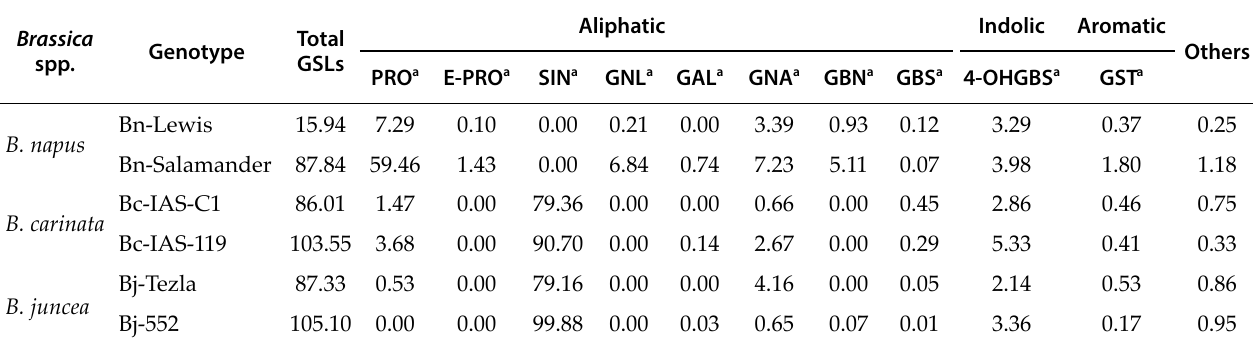
Table 2. Glucosinolate profiles and concentrations (μmol g -1 dry weight) in seeds of the selected Brassica napus, B. carinata and B. juncea